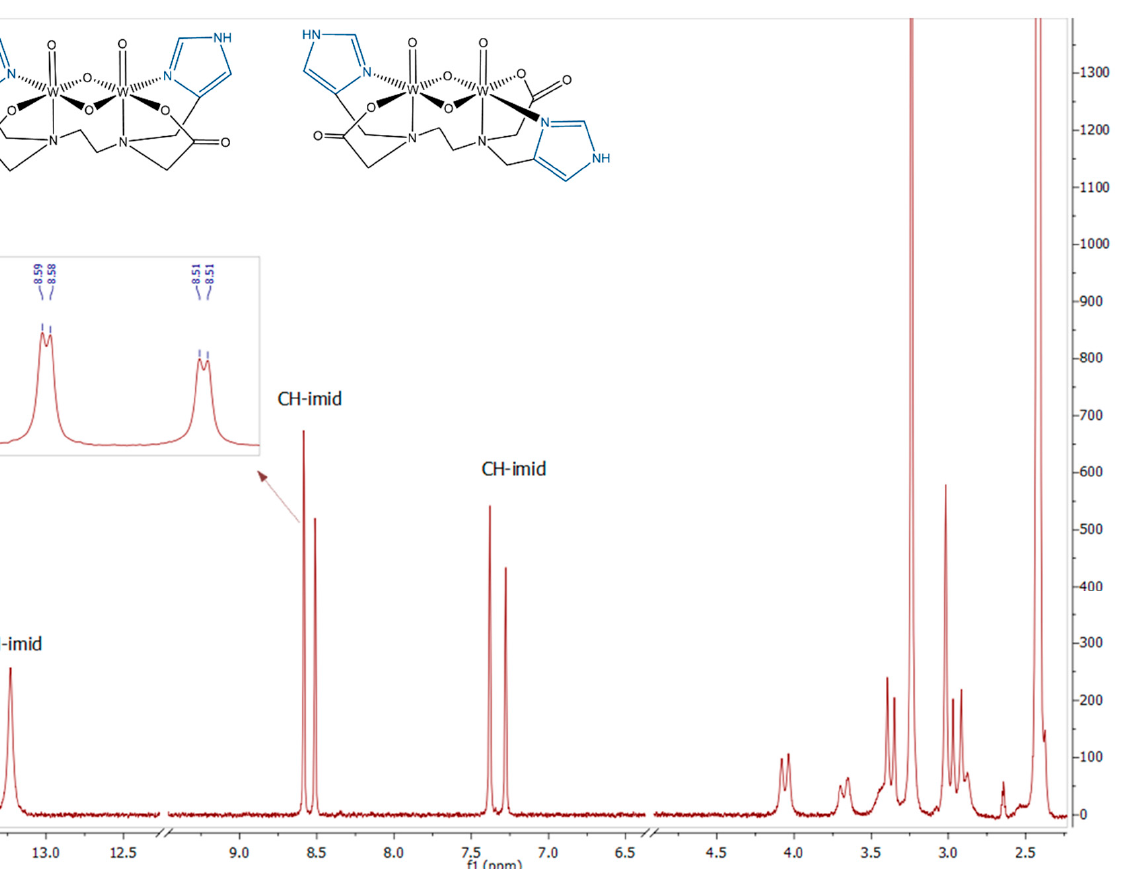
Figure 4. 1 H NMR spectra of both isomers of [W 2 O 4 (L2)] ( 2a top and 2b bottom) in DMSO-d 6 at RT; the structure of the cis isomer ( 2a ) was confirmed by X-ray crystallographic analysis. The two NH 2